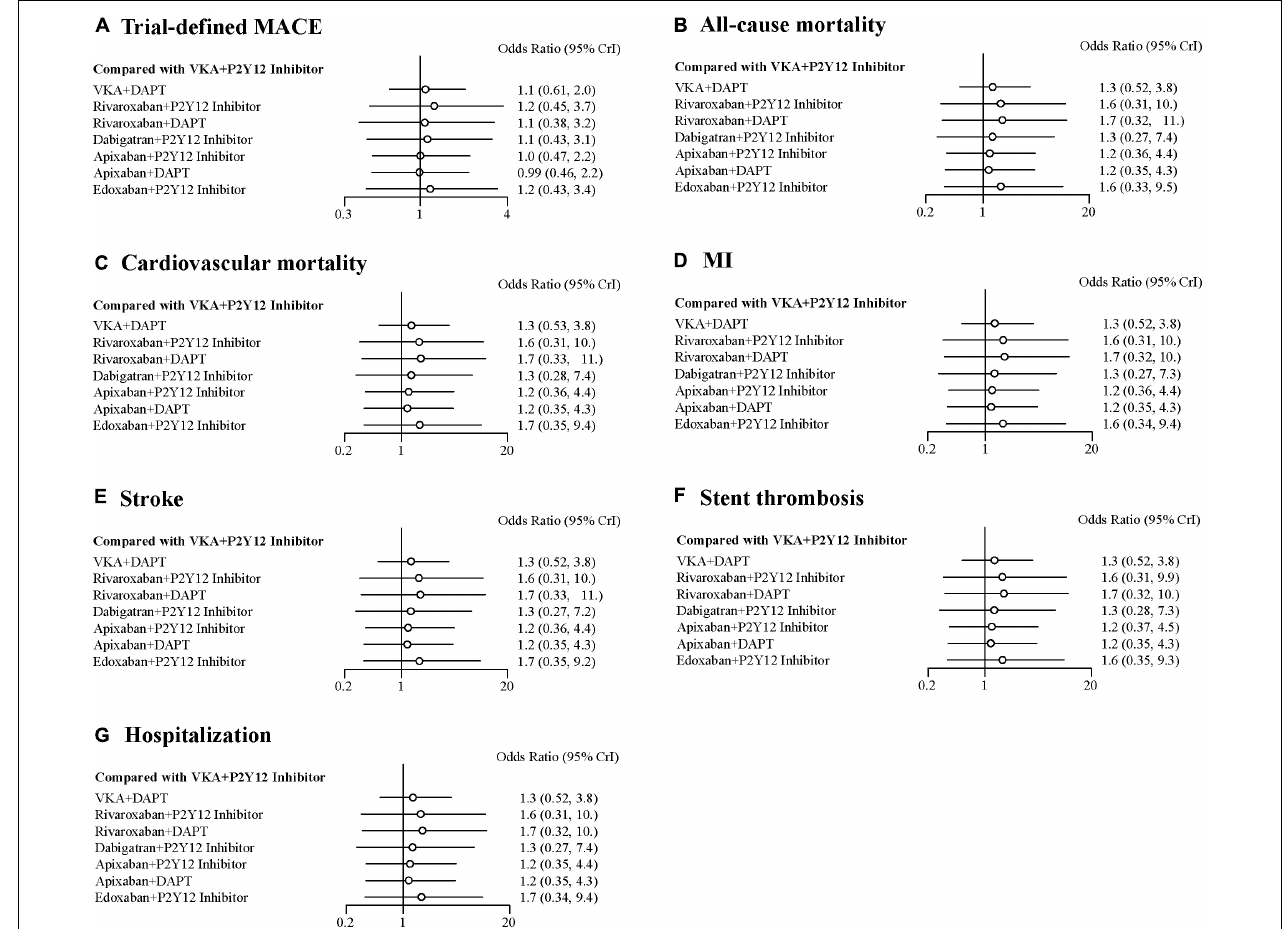
FIGURE 4 | Forest plots for efficacy outcomes. (A) Trial-defined major adverse cardiovascular events (MACE). (B) All-cause mortality. (C) Cardiovascular mortality. (D) Myocardial infarction (MI). (E) Stroke. (F) Stent thrombosis. (G) Hospitalization.